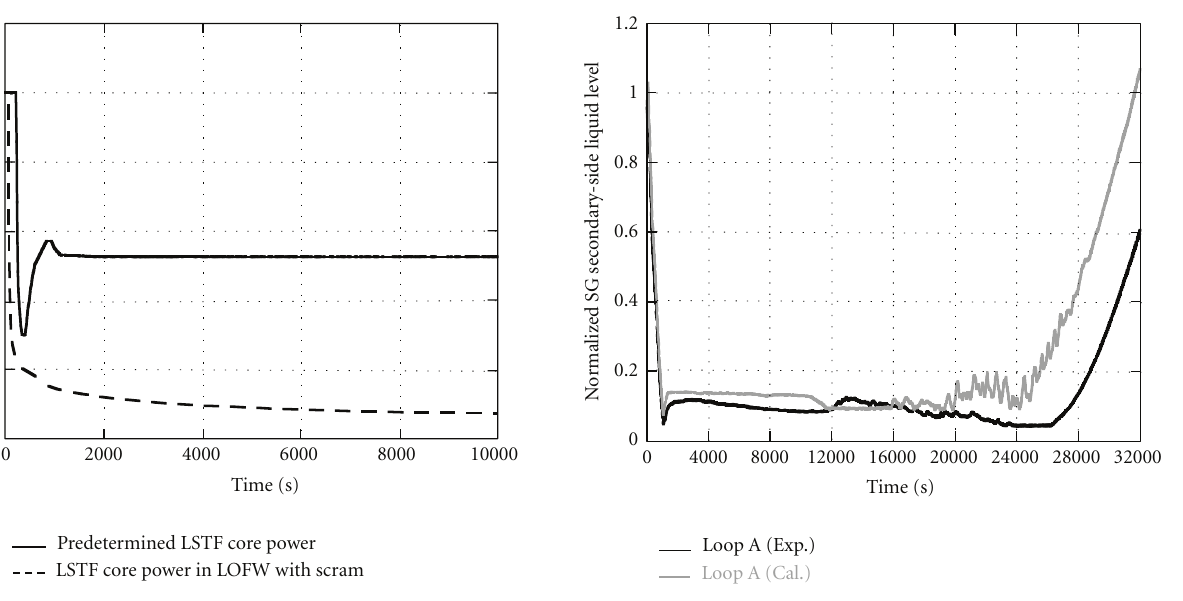
Figure 7: LSTF and RELAP5 results for SG secondary-side collapsed liquid level in loop with PZR.